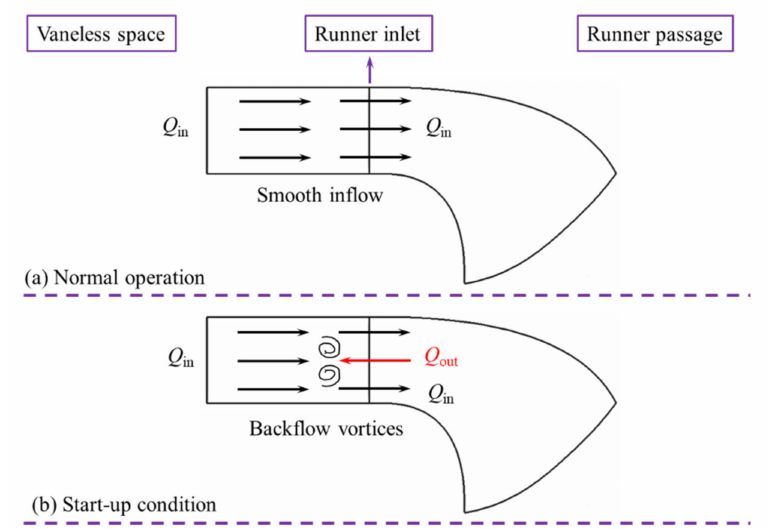
Figure 6. Schematic of discharge distributions in normal and start-up